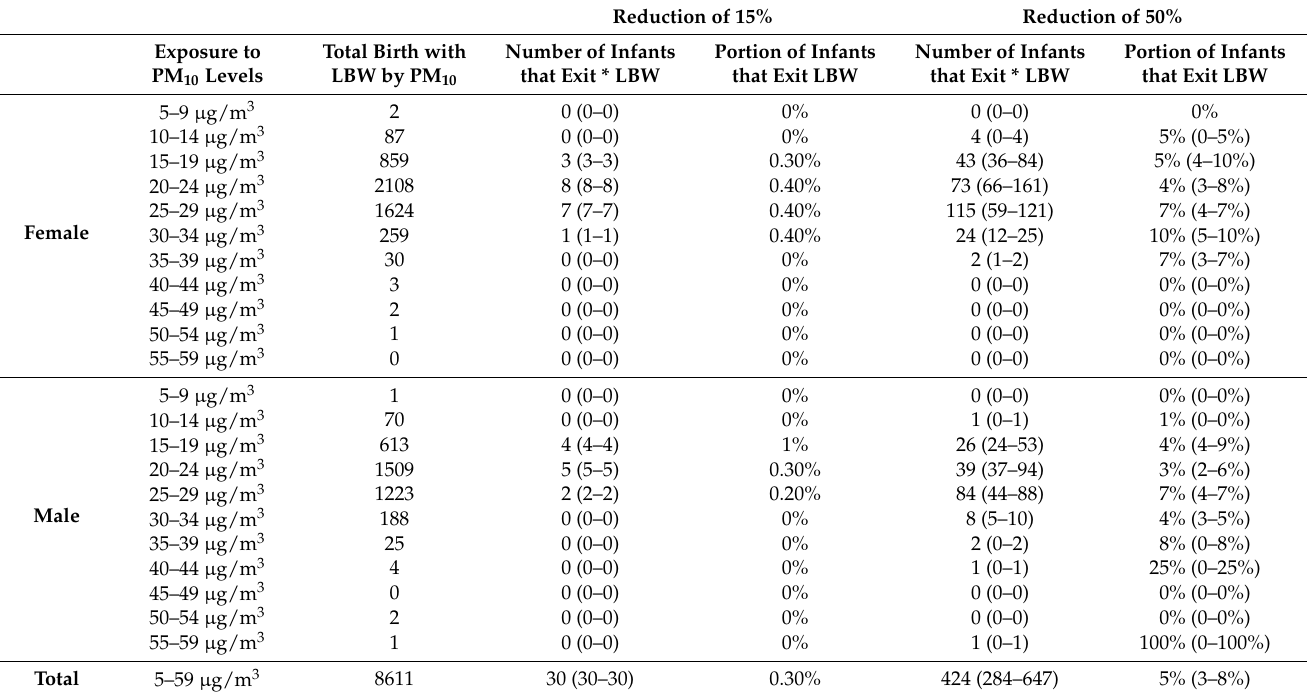
Table 4. LBW by Infant sex and exposure to PM 10 levels with a scenario of a reduction of 15% of the annual PM 10 AQG